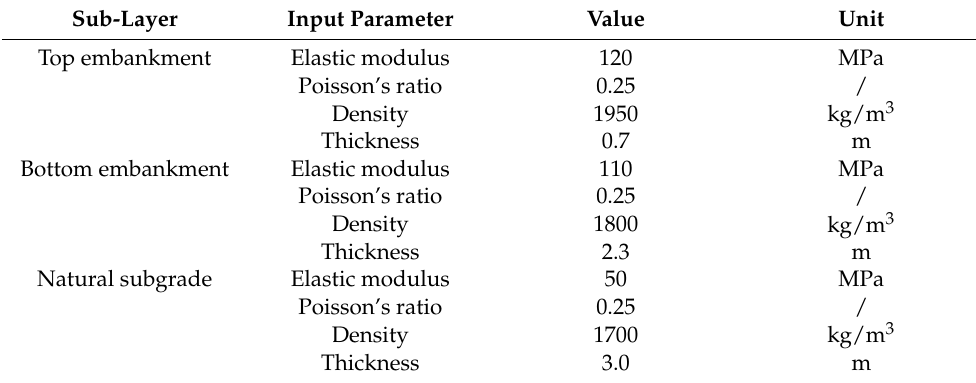
Table A2. Model input parameters of the sub-layers in the composite